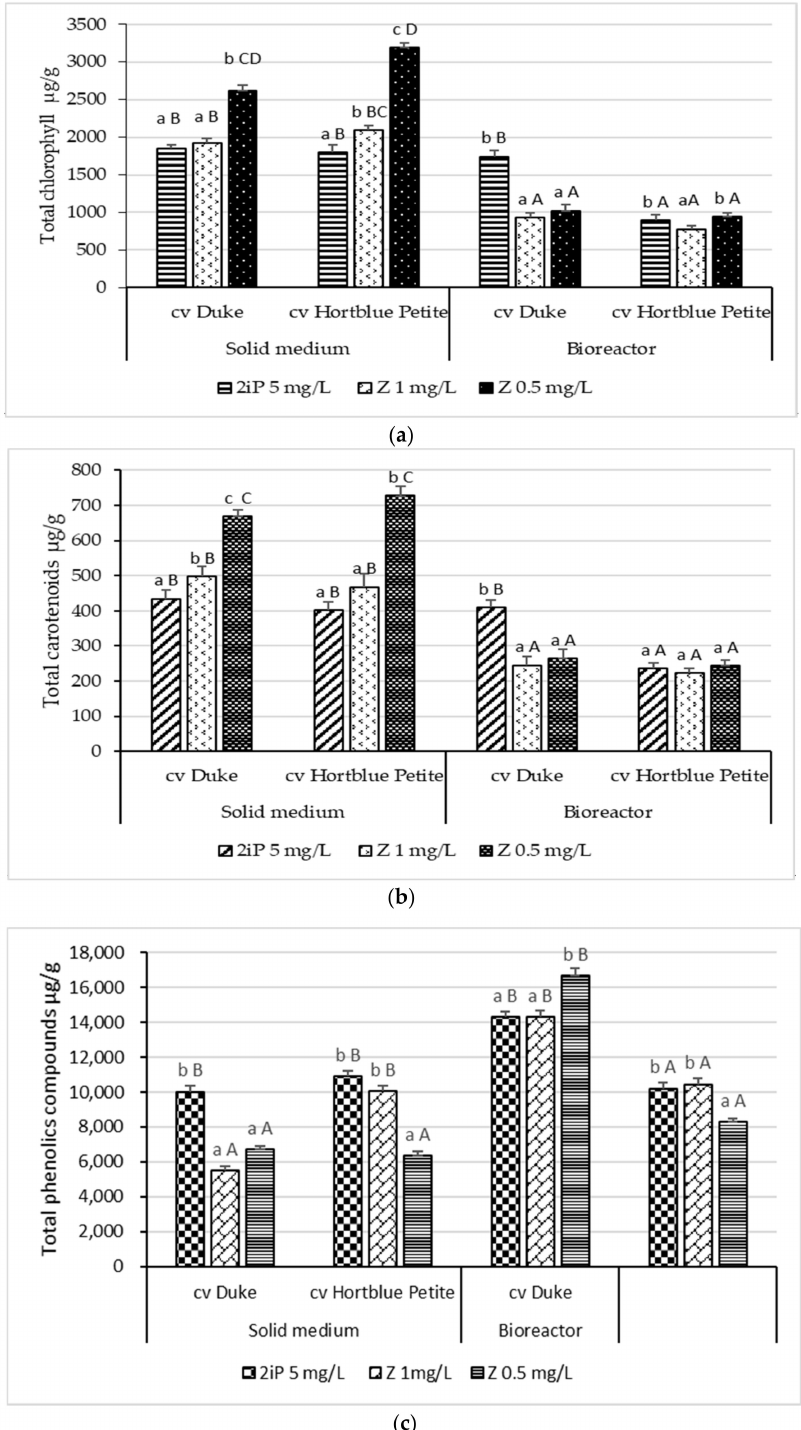
Figure 3. Total chlorophylls content in highbush blueberry samples, expressed as µ g/g sample ( a ) . Total carotenoids content in blueberry samples, expressed as µ g/g sample ( b ). Total phenolics content in blueberry samples, expressed as µ g/g sample ( c ). Different lowercase letters indicate significant differences between the means of the same cultivar variations of growth regulators. Capital letters indicate significant differences between the means of all analysed samples according to Tukey’s HSD test ( p <